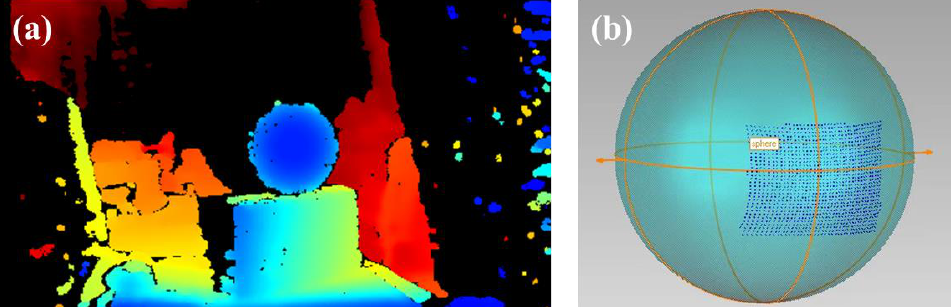
Figure 17. The 3D reconstruction of the sphere object using D455. ( a ) Depth map; ( b ) Three- dimensional reconstruction result.